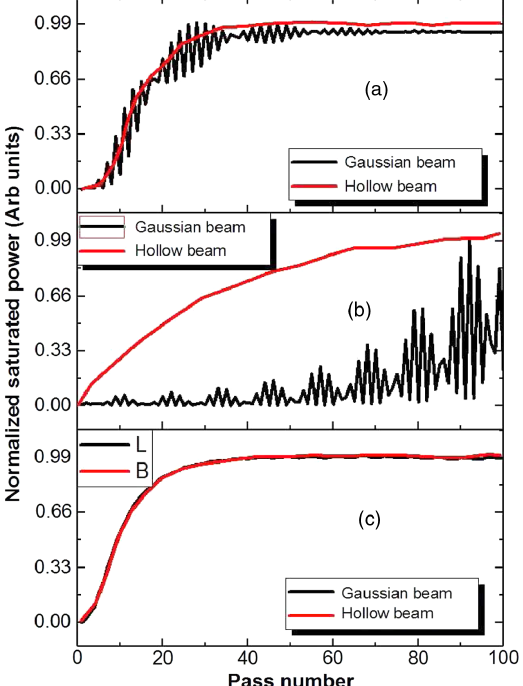
FIG. 6. Out-coupled power as a function of pass number in the FEL resonator for the hollow and Gaussian beams, for (a) λ ¼ 10 μ m, (b) λ ¼ 25 μ m and (c) λ ¼ 50 μ m. In all cases g ¼ − 0 . 6